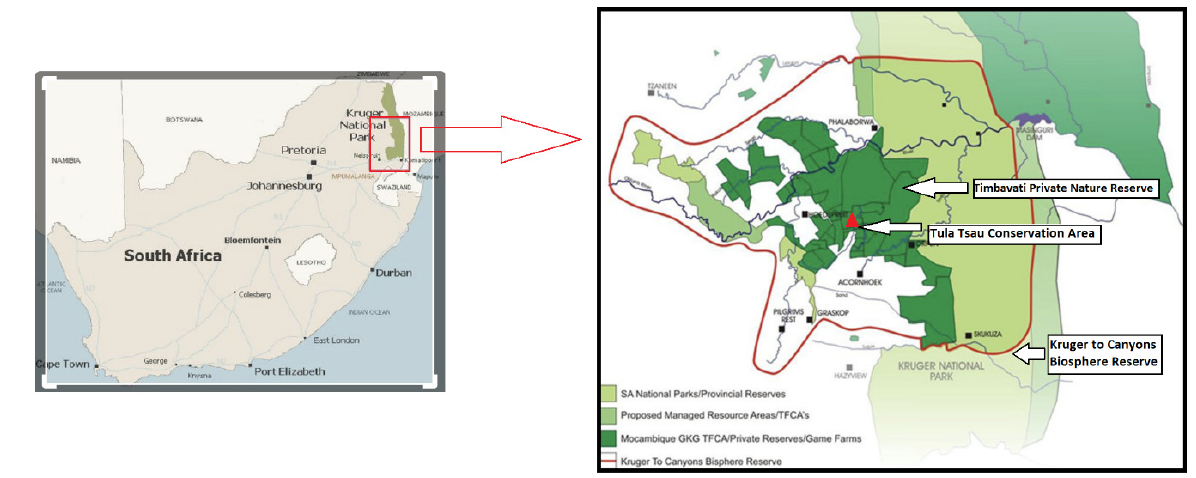
Figure 1. Location of the Tula-Tsau Conservation Area, Kruger to Canyons Biosphere Reserve, South Africa.